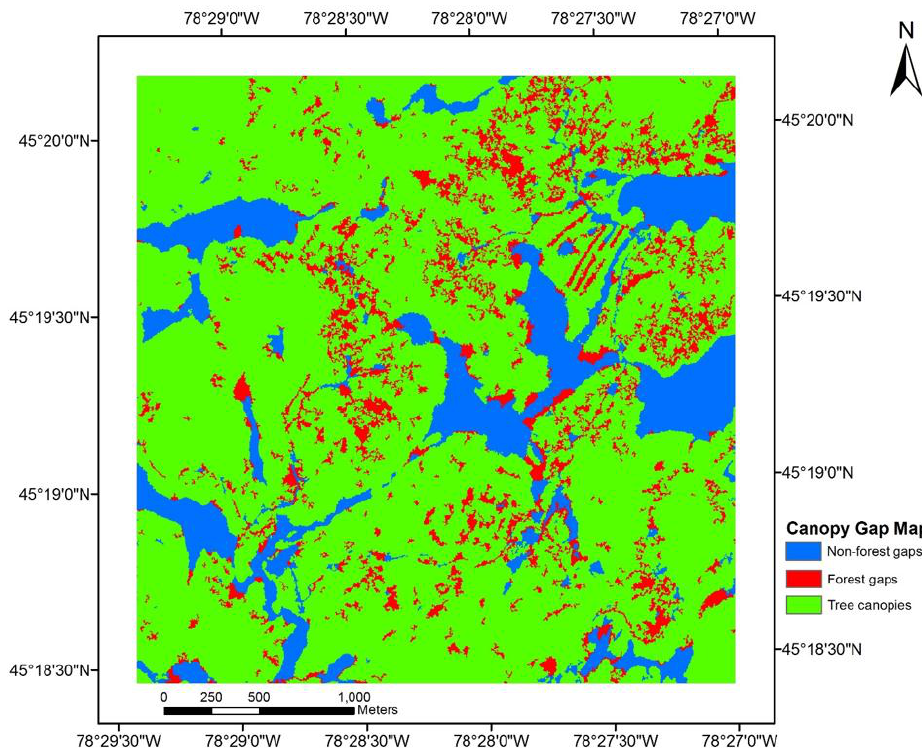
Figure 8. Final thematic map of non-forest gaps (blue), forest gaps (red), and tree canopies (green).